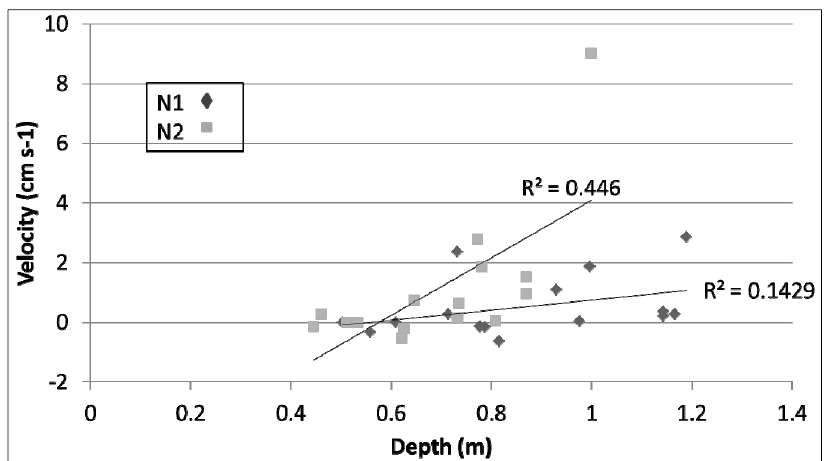
Figure 4. Relationships between measured stream velocity and sonde depth for both N1 and